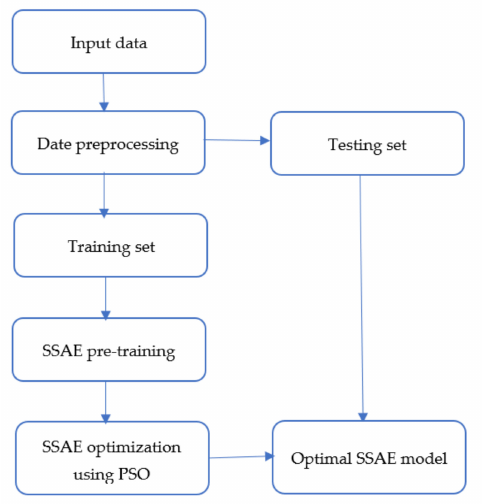
Figure 1. Flowchart of the proposed